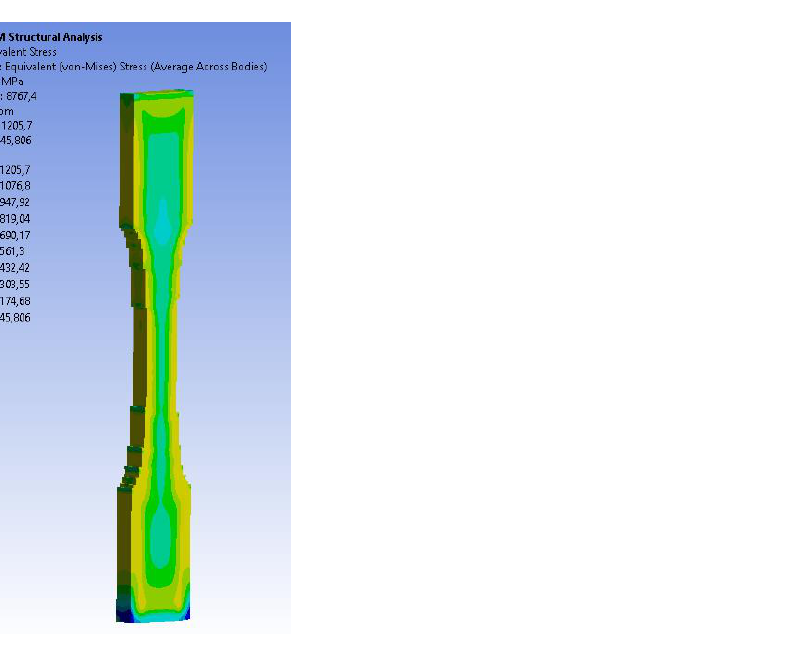
Figure 4. Residual stresses simulated upon the removal of the